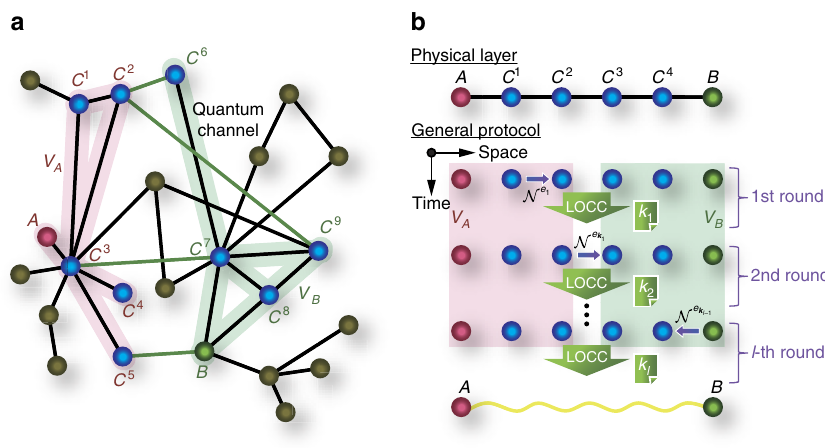
Figure 1 | Quantum internet and the most general protocol. ( a ) A general quantum internet where Alice ( A ) and Bob ( B ) request its internet protocol to supply them with resources for quantum communication, such as a secret-key and quantum entanglement. Accordingly, the protocol chooses a quantum network G (which might be a quantum subnetwork) associated with a directed graph G ¼ ( V , E ). The set V of vertices is composed of the nodes